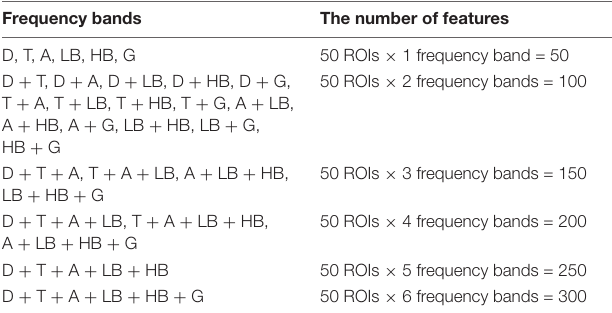
TABLE 2 | Thirty power spectrum density (PSD) feature sets constructed by combining different frequency bands and the number of features for each feature set. Fifty features were extracted for each frequency